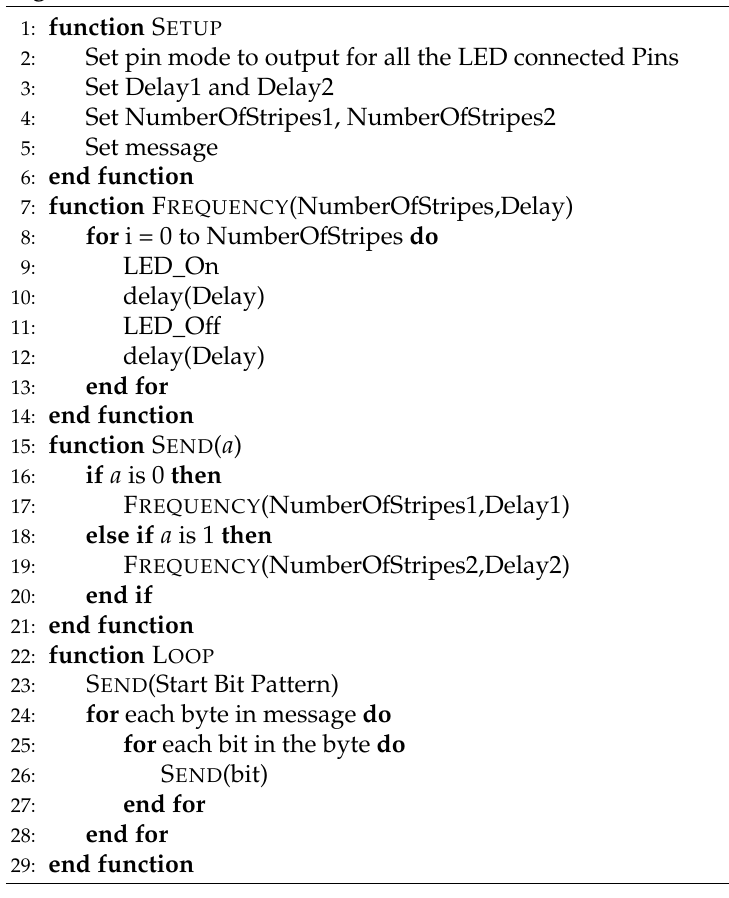
Algorithm 4 BFSOOK Modulation for VLC